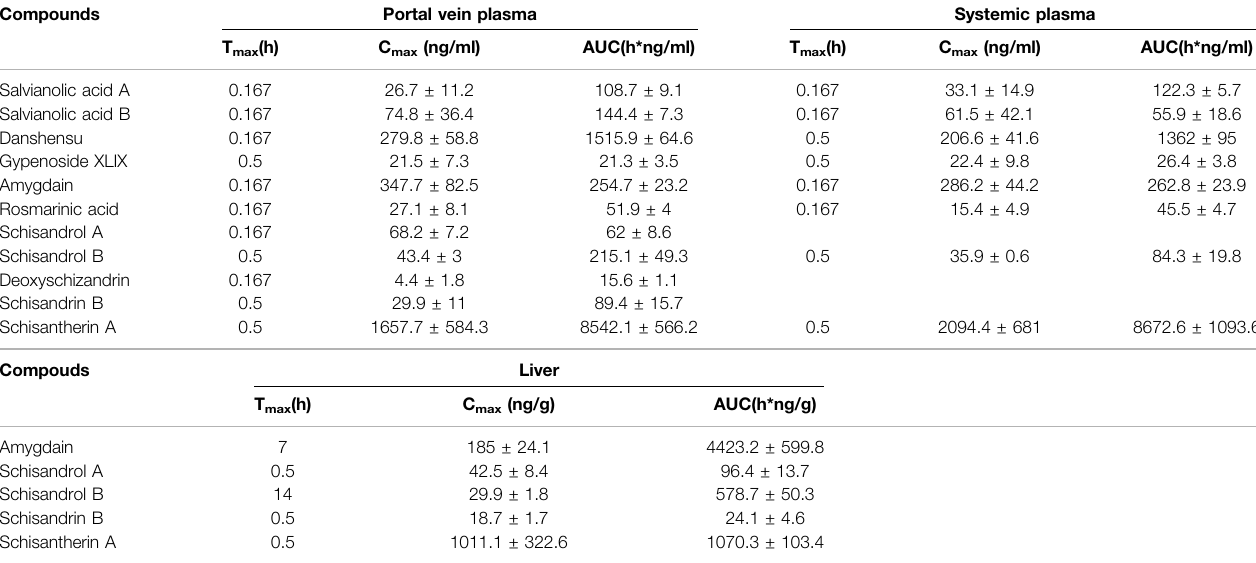
TABLE 1 | The PK parameters of 11 compounds in the portal vein plasma, systemic plasma and liver, following oral administration of FZHY decoction in rats. Compounds Portal vein plasma